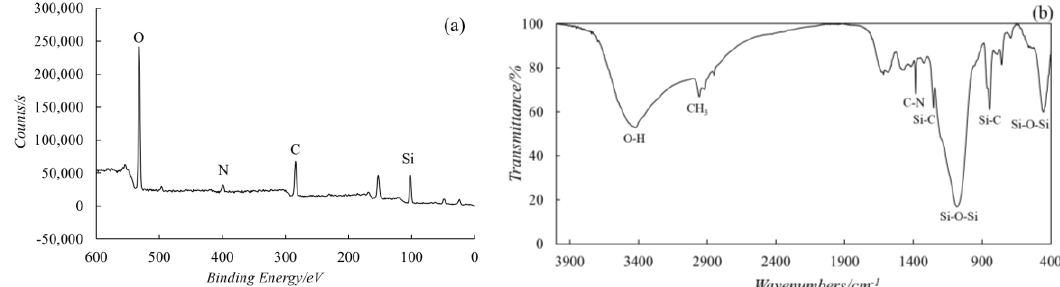
Figure 7. ( a ) XPS survey of the superhydrophobic particles; ( b ) FTIR image of the superhydrophobic particles.